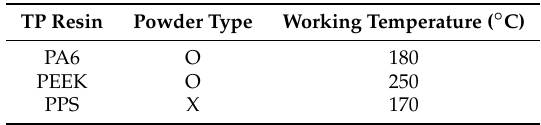
Table 1. Powder type and working temperature of thermoplastic(TP) resin.